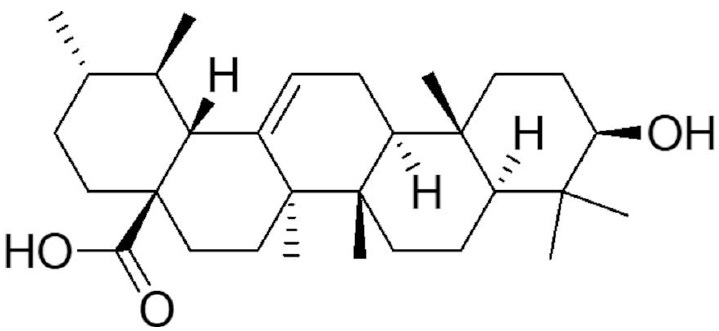
Figure 1. Chemical structure of UA.